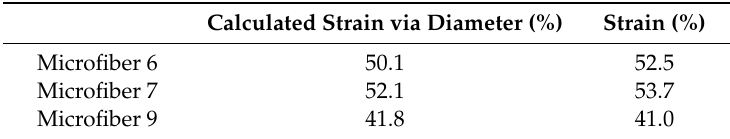
Figure 7. Microfiber with several particles on the surface for tracking the elongation. White arrows show the change in length during the necking propagation. Table 2. Comparison of the strain calculated based on the diameter reduction and the displacement of surface